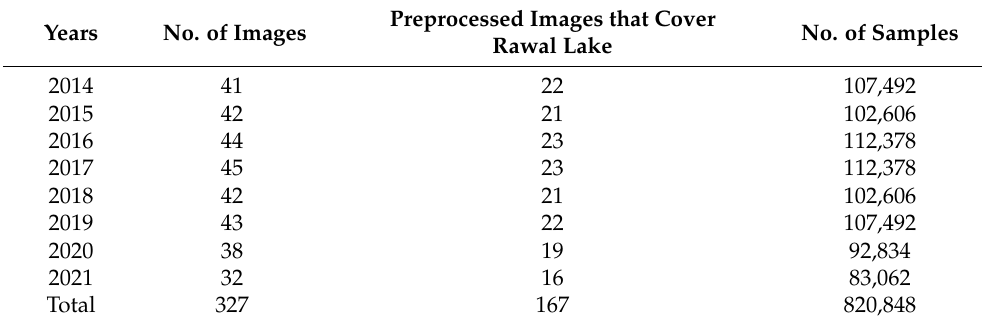
Table 1. Numbers of satellite images, preprocessed images and sample points retrieved for the years 2014 to 2021. Years No. of